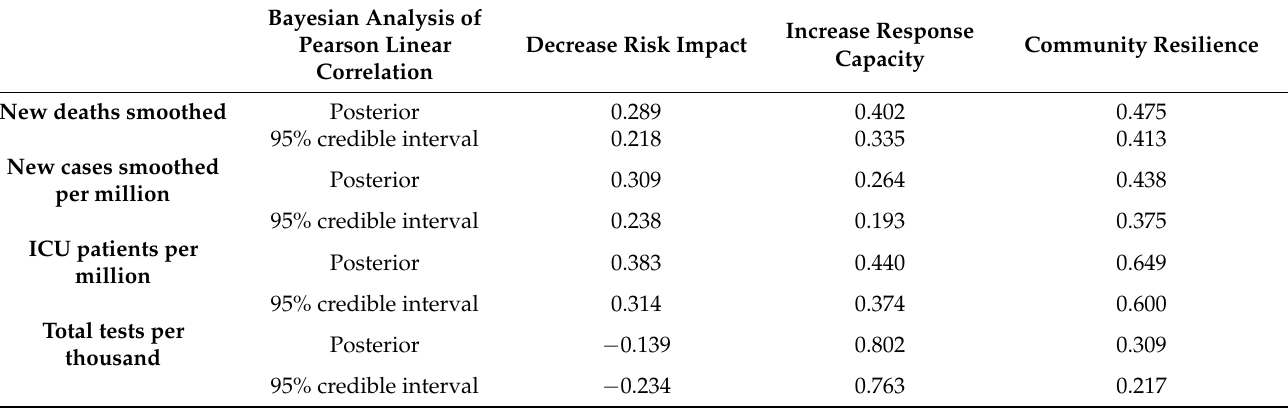
Table 3. Analysis of the measures taken to manage the pandemic and the main indicators of the evolution of the